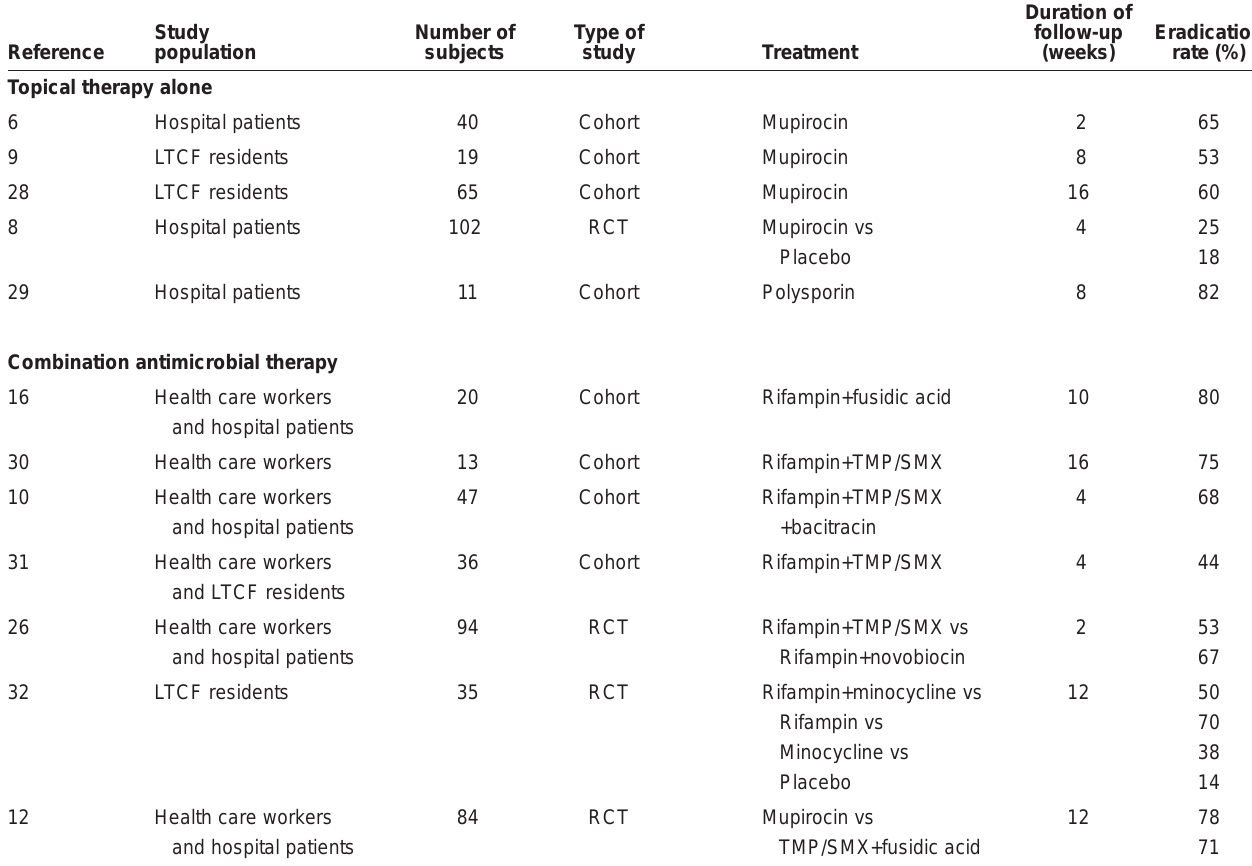
TABLE 2 Summary of studies of methicillin-resistant Staphylococcus aureus decolonization therapy with follow-up of at least two